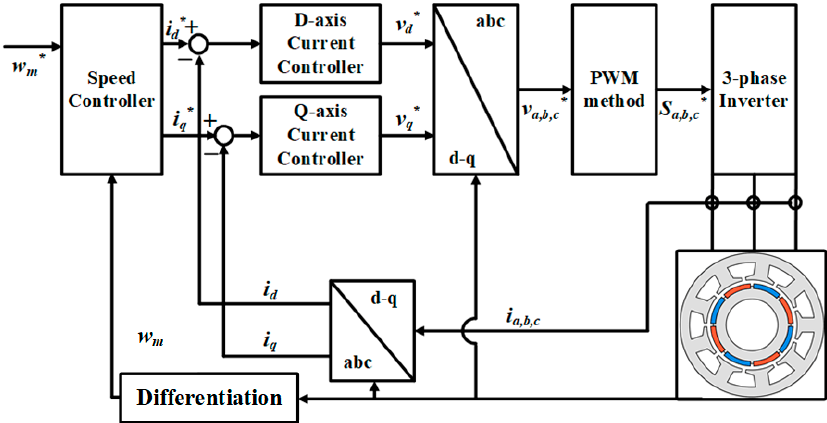
Figure 2. Vector control diagram of PMSM for dynamic analysis.